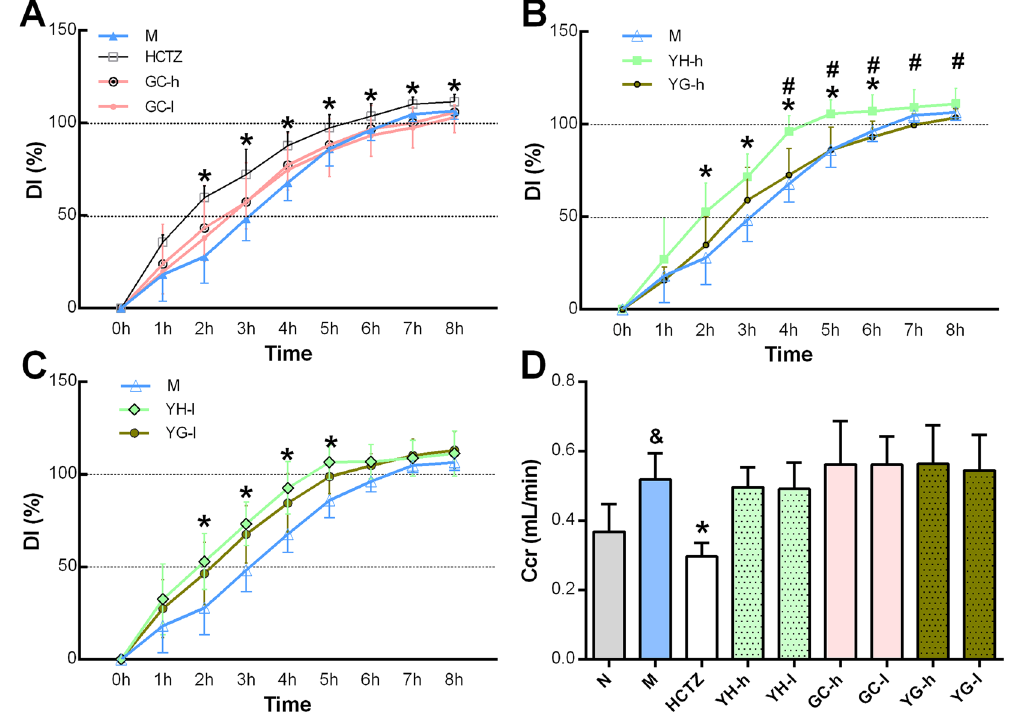
Figure 2. YH increased urine excretion and GC counteracted YH’s activity. ( A to C ) Accumulated urine output was calculated from animal weight loss 0 to 8 hours after water loading. The data were represented as diuresis index (DI), which means the percentage of weight loss in total water loading (n = 15). M group means the water loading model group. YG means combination of YH and GC at high or low dose. YH had diuretic activity at both high and low dose, however, when it combined with GC, the activity was counteracted. ( D ) The glomerular filtration rate (GFR) indicates primary urine amount, and can be calculated as plasma creatinine clearance rate (Ccr) (n = 8–10). Water loading can increase GFR, while HCTZ can decrease it. It’s found that YH’s diuretic effect and GC counteraction activity were not related to GFR. Other key factors in urine formation process are summarized in Supplementary Fig. S1. * P < 0.05 when HCTZ, YH-h and YH-l compared to M group; & P < 0.05 compared to N group; # P < 0.05 when YG-h group compared to YH-h